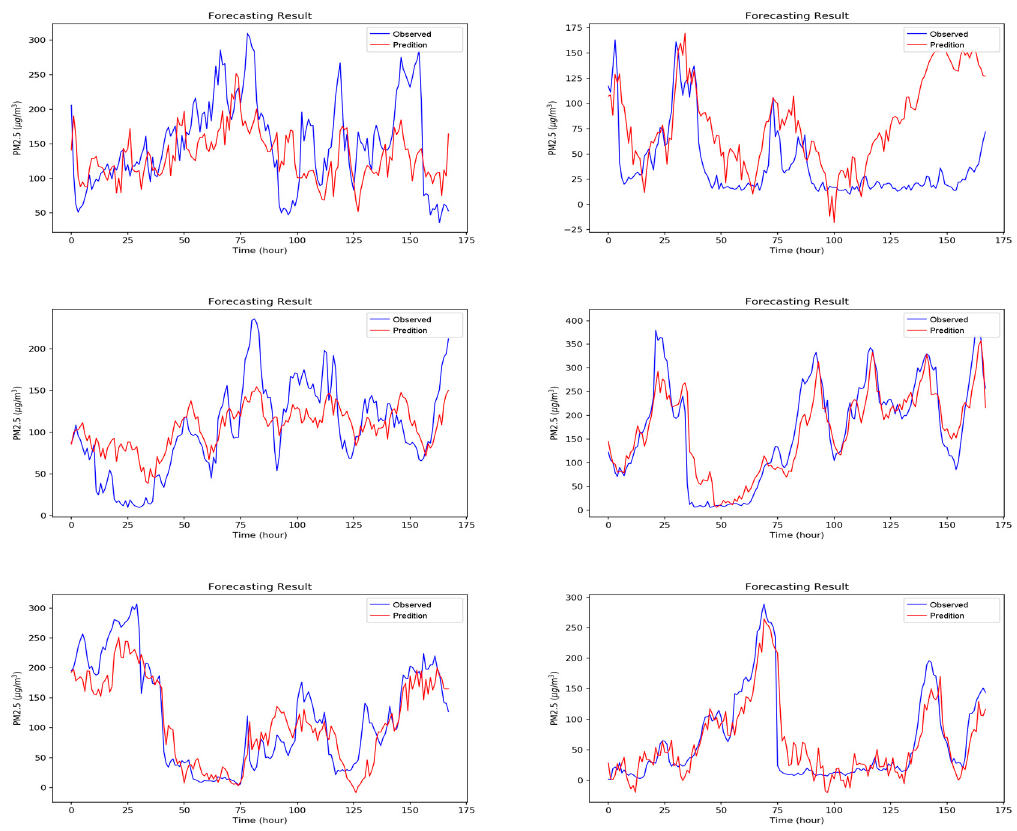
Figure A1. The forecasting results of Support Vector Machine (SVM).